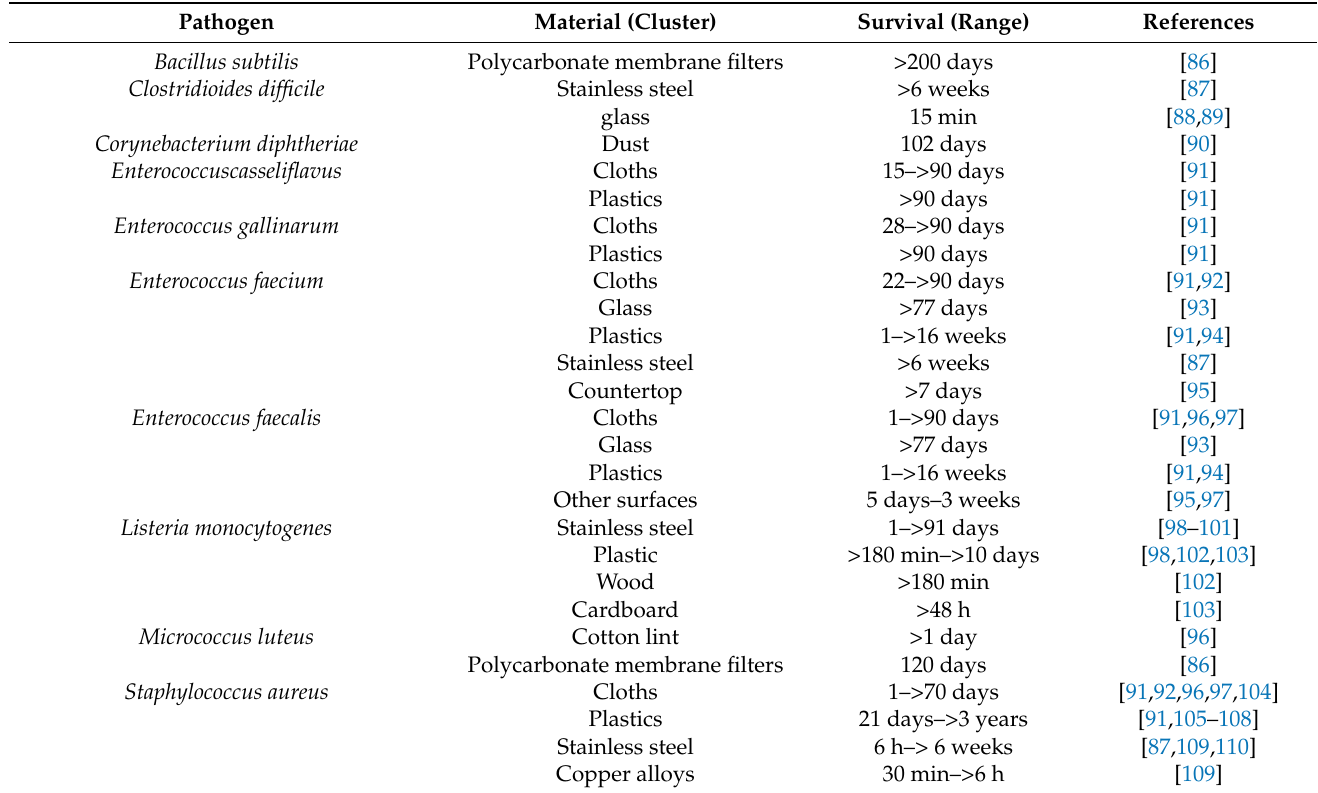
Table 3. Survival of gram-positive